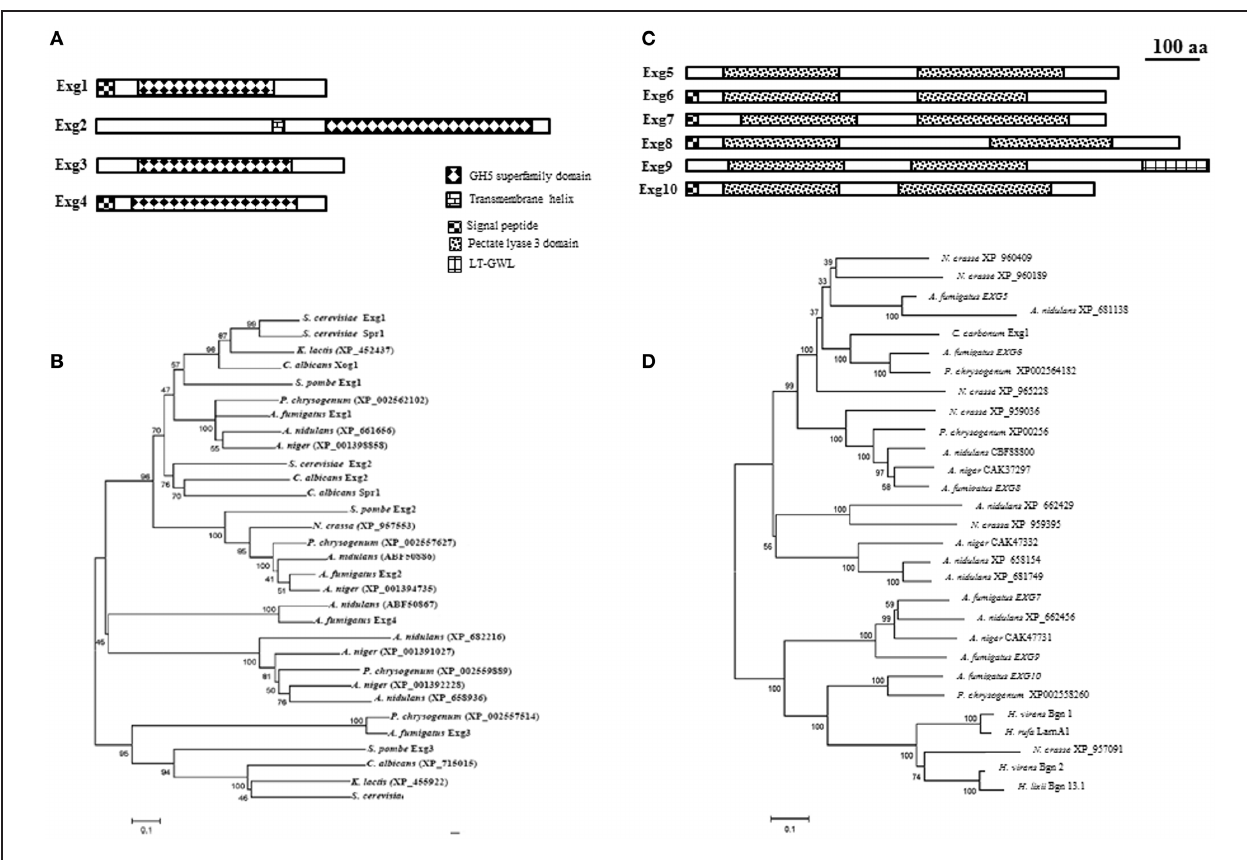
FIGURE 2 | Domain organization and phylogeny of A. fumigatus exo β -1,3-glucanases. Protein domains identified using SignalP 3.0, big-PI, TMHMM v. 2.0, and CD search (100 aa: protein length proportional to 100 amino acids). Phylogenetic trees of A. fumigatus were built by Neighbor Joining. Numbers next to nodes represent bootstrap values calculated using 1000 repetitions. A. fumigatus proteins were